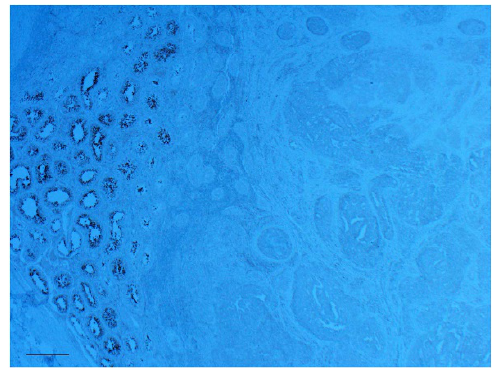
Figure 4 | IHC staining for DNAAF1 expression in available tumour tissue from mutation carriers. IHC showing positive DNAAF1 expression in surrounding normal tissue (left) but loss of expression within the tumour (middle and right). Data are shown for tumour from